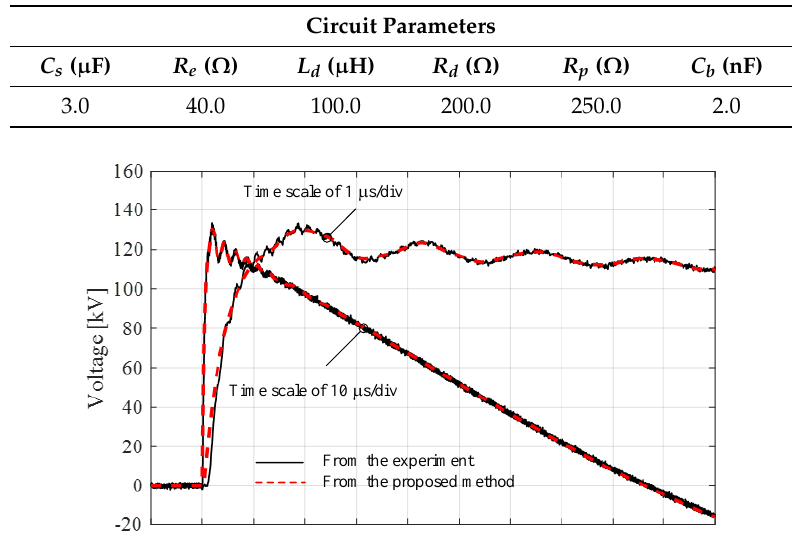
Figure 15. Comparison of the generated impulse voltage waveforms collected from the experiment and computed by the proposed method.